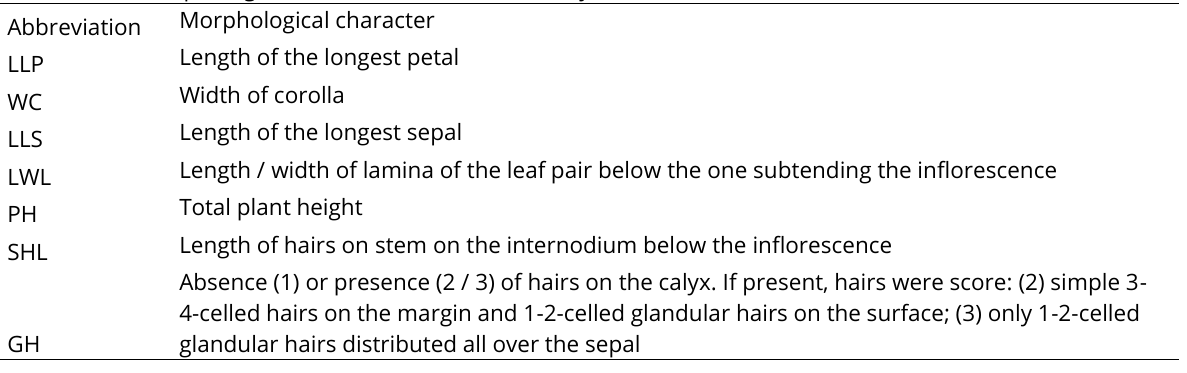
Table 2: Morphological characters used in the analysis with their abbreviation